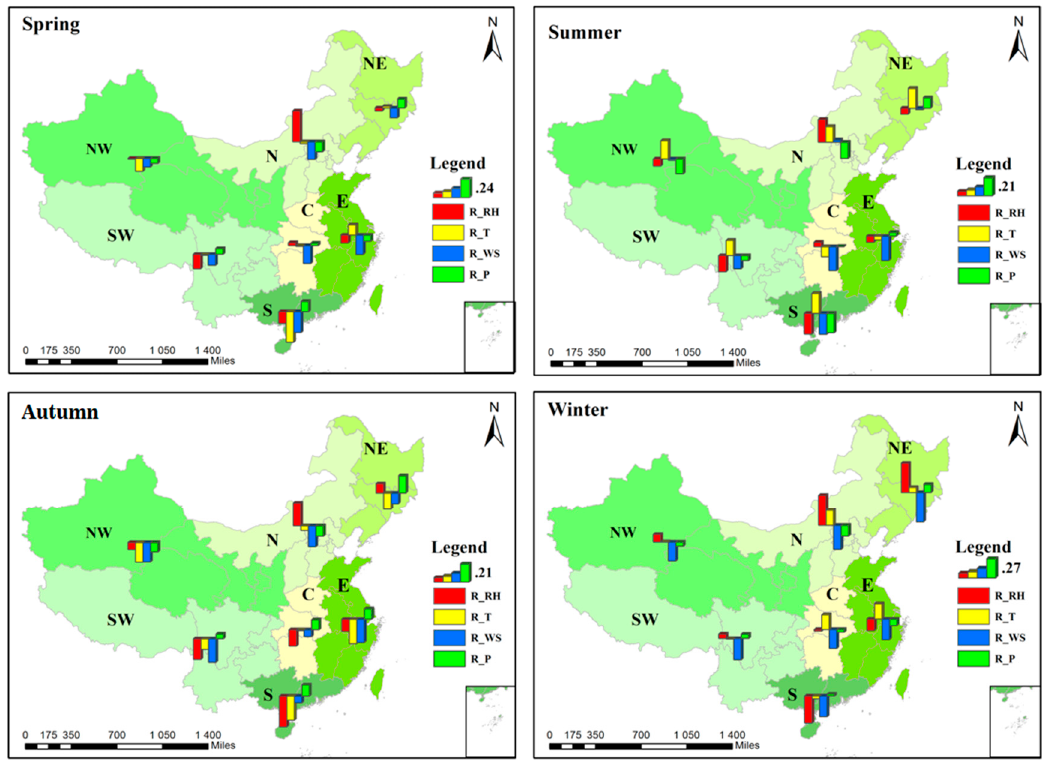
Figure 10. Seasonal distribution of the correlation coefficient (r) value histograms in the seven regions. Table 3. The major and minor influencing factors of the seven regions (the color of each cell stands for the sign and magnitude of the correlation coefficient (r) value, where red stands for a positive correlation and blue stands for negative).